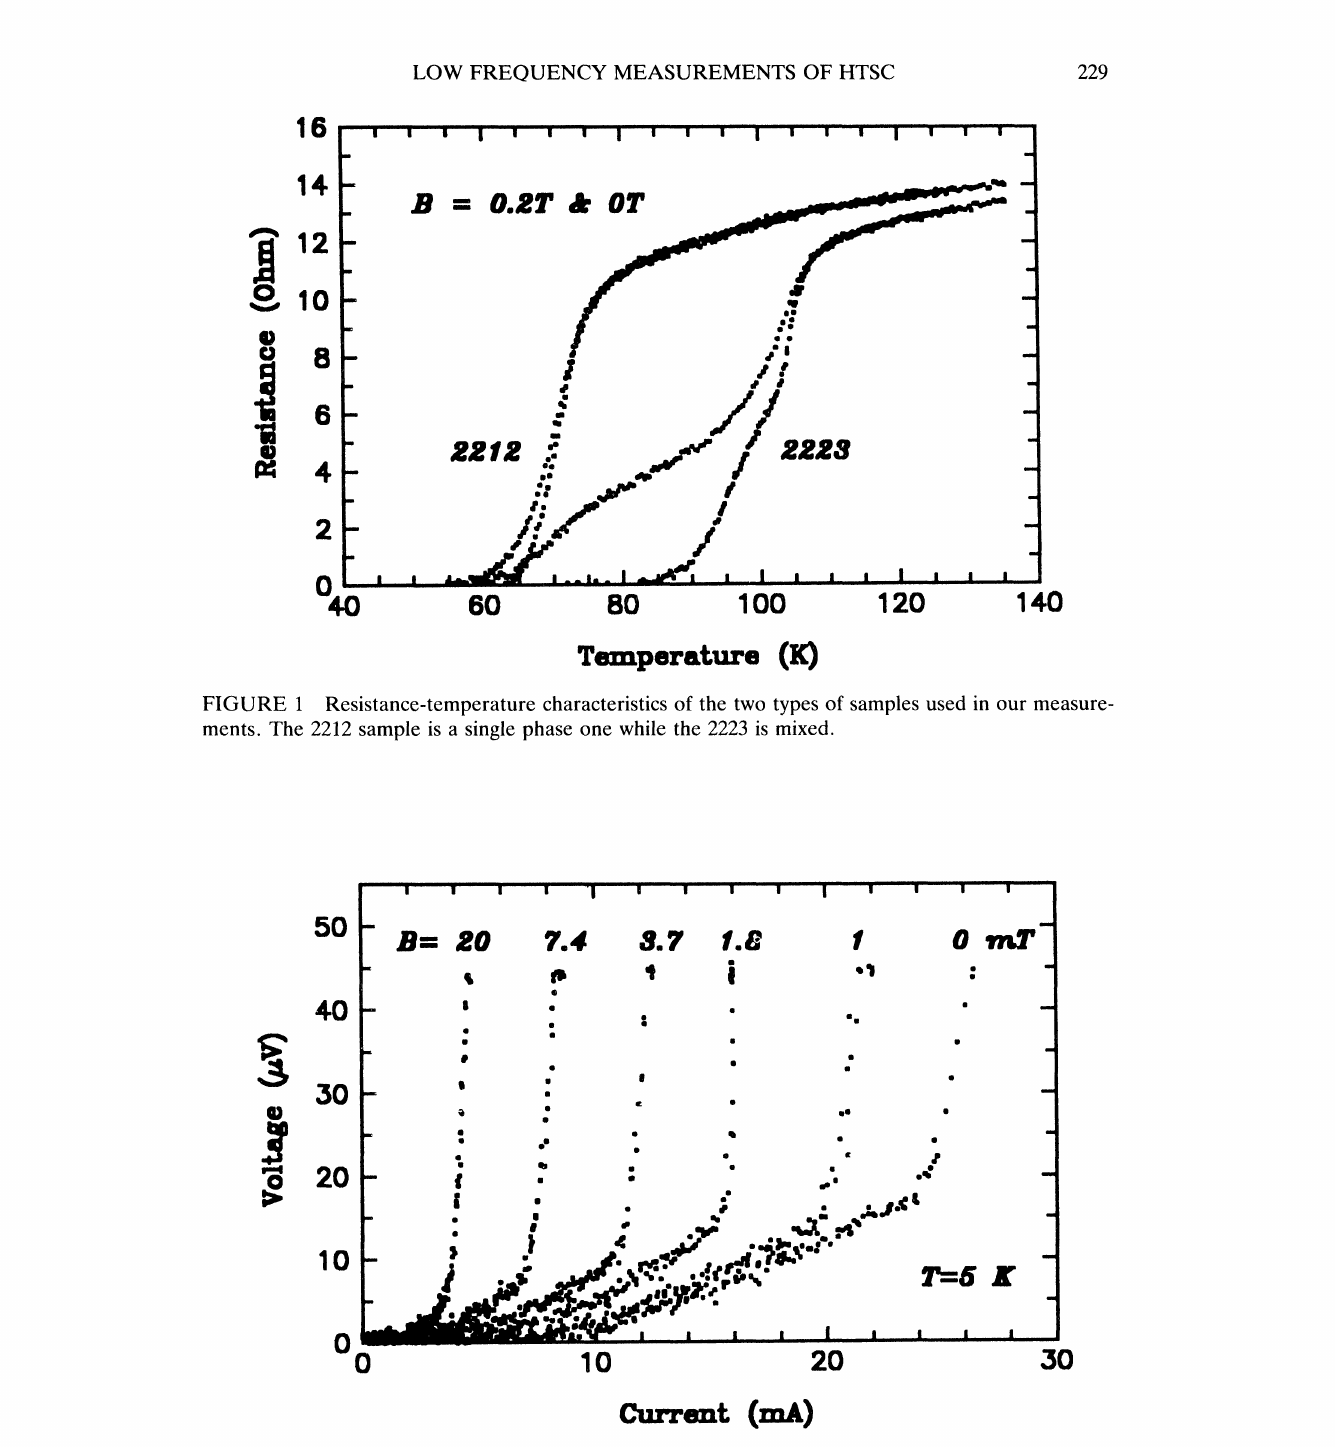
FIGURE 2 Current-voltage characteristics in different magnetic fields. The sample width is